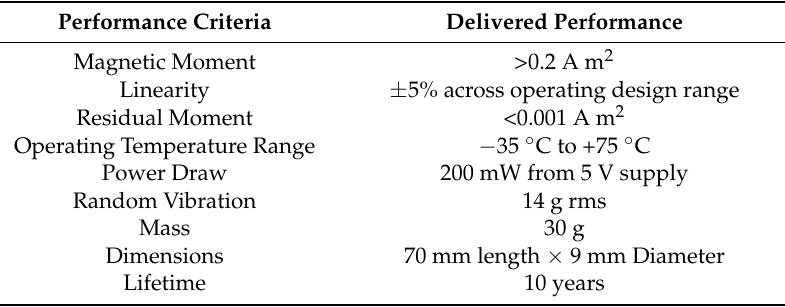
Table 16. NSS Magnetorquer Rod Data